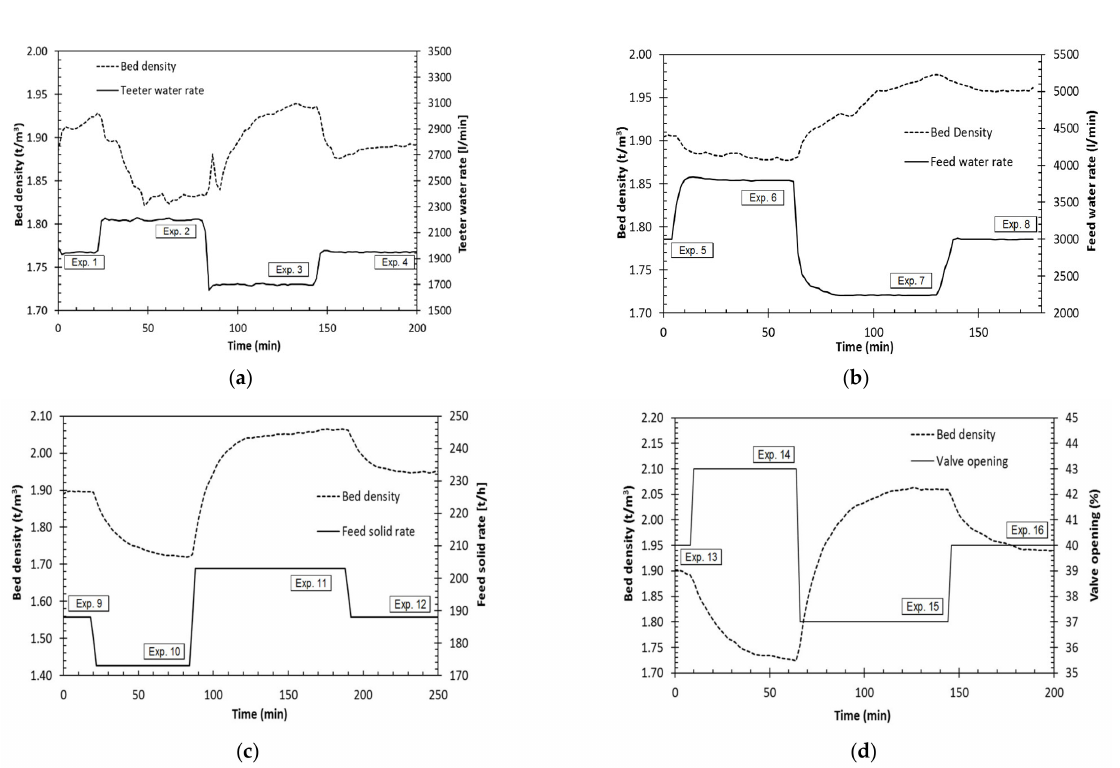
Figure A5. Bed density and manipulated variable as a function of time for industrial experiments ( a